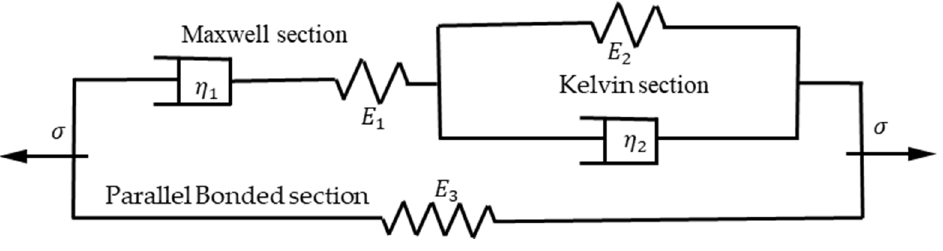
Figure 5. Burger’s Bonded model.